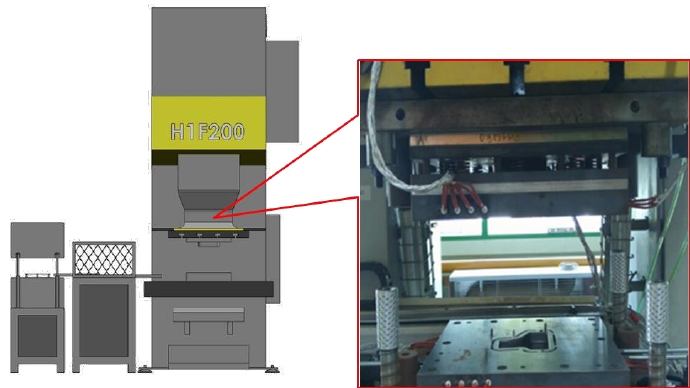
Figure 3. Press equipment and installed die for hot stamping test of T-type parts.